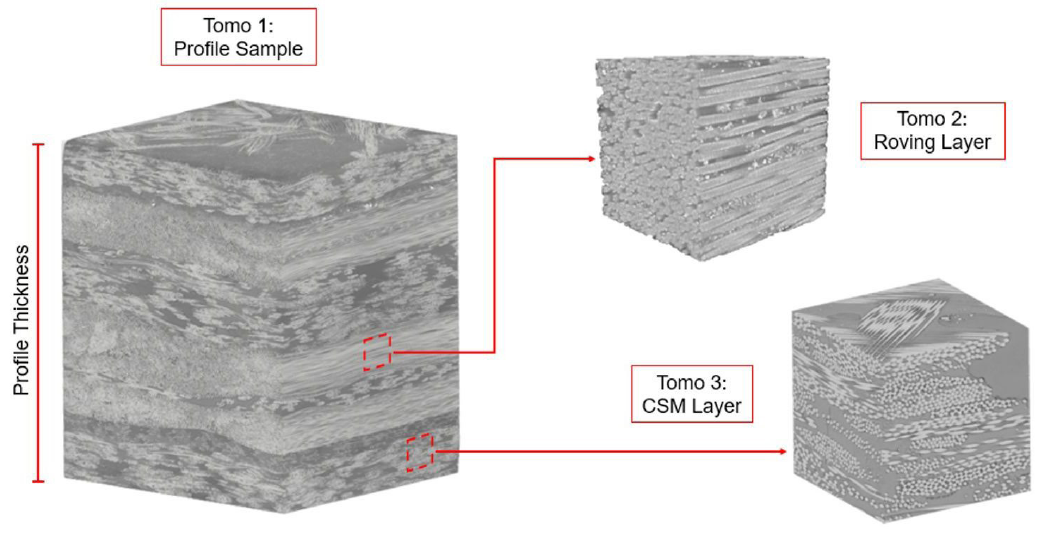
Figure 3. Micro-CT acquisition of the profile sample, roving layer and CSM layer. Table 1. Parameters of micro-CT scanning used to digitalize the samples of pultruded GFRP.